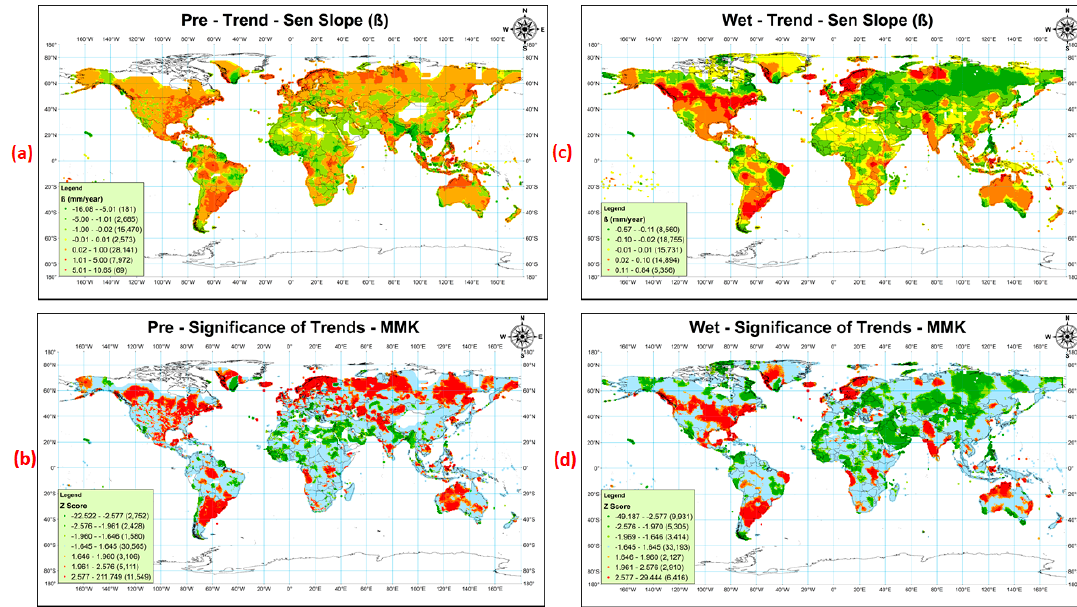
Figure 2. Sen’s slope trends and its significance using MMK test for Precipitation ( a ), ( b ) and Wet-day frequency ( c ), ( d ). The presented trends in subplot ( a ), ( c ) are divided to represent the magnitude of the trend, that is, the trends close to zero are shown by light shades of green and red (green for decreasing and red for increasing). The darker shade of the green and red color shows higher trend magnitude. The legends of subplots ( b ), ( d ) are divided according to the significance level of MMK tests, i.e., α = 1, 5, and 10%, standard Z static is ±2.576, ±1.96, and ±1.645, respectively.